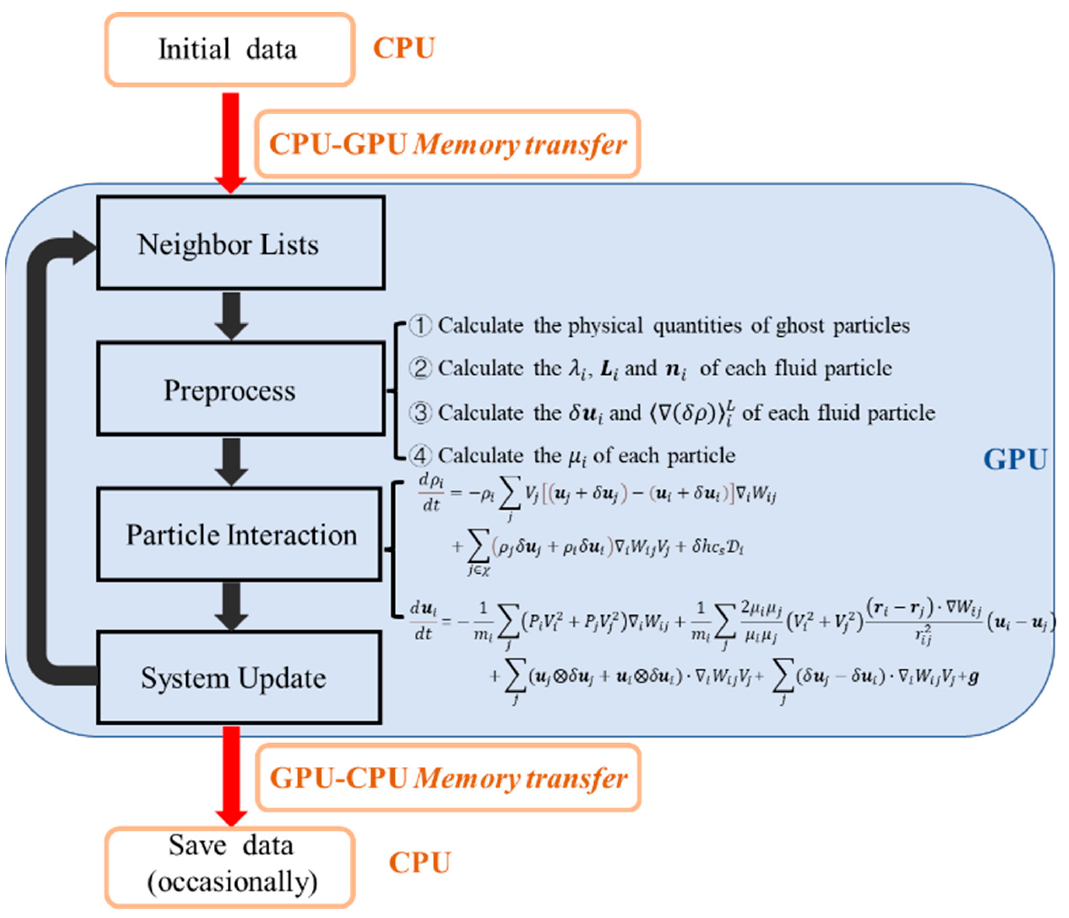
Figure 4. Flow diagram of the SPH model implemented on a GPU.